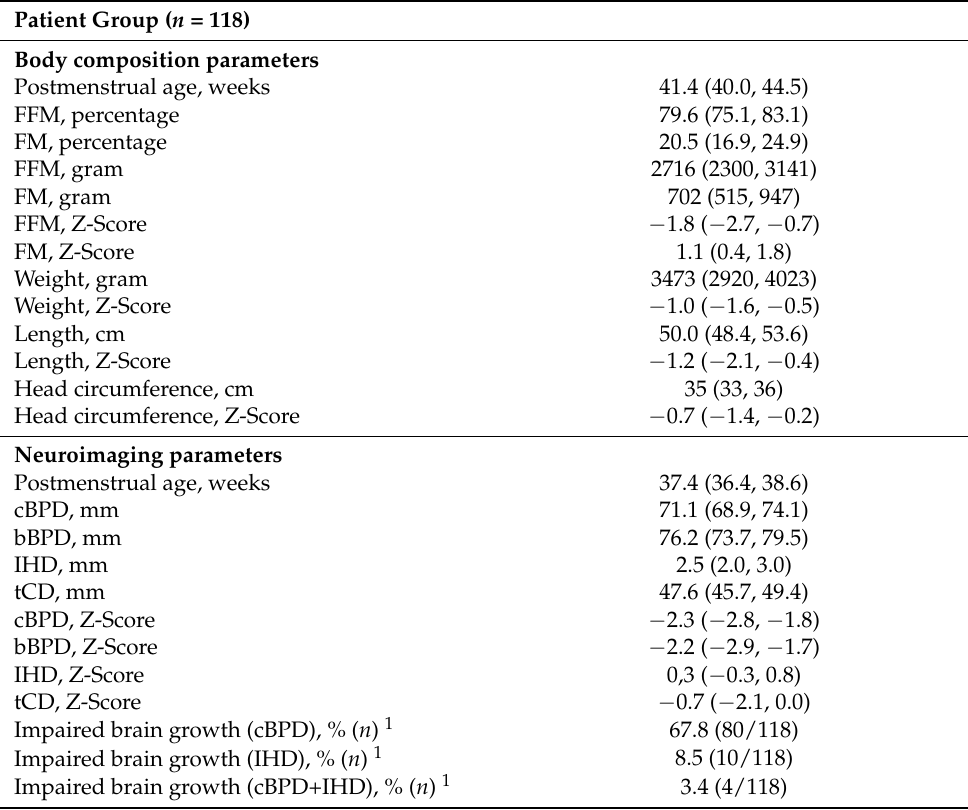
Table 2. Body composition and brain size parameters at term equivalent